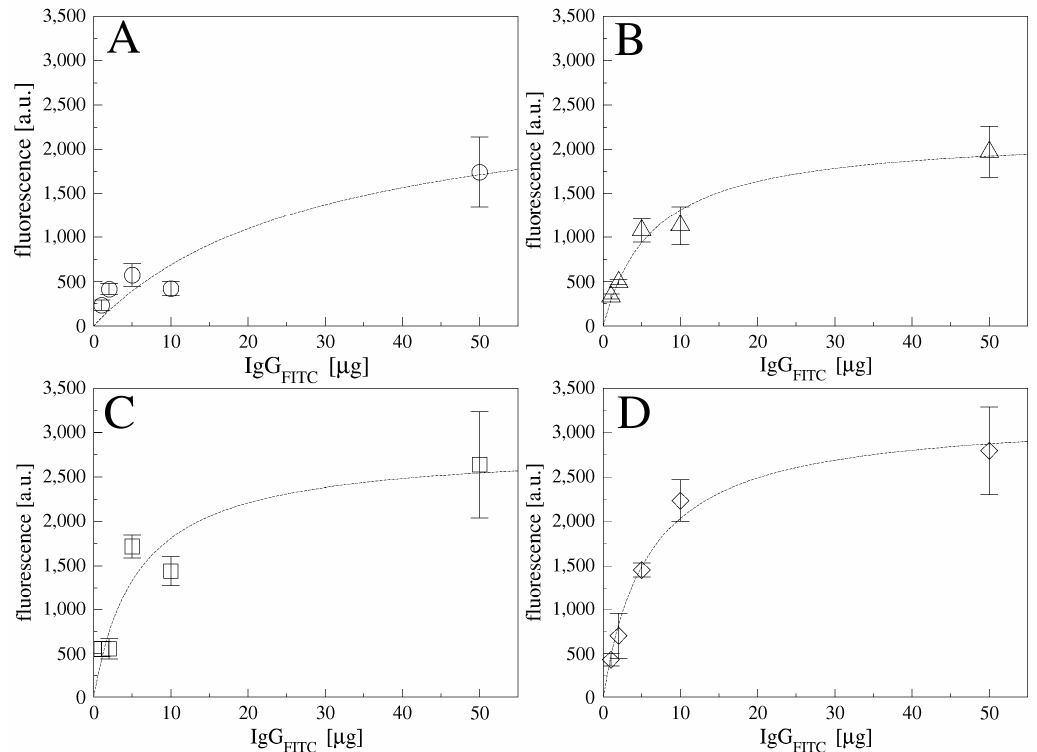
Figure 2. IgG FITC fluorescence on gold substrates functionalized at different concentration for different times: 20 min ( A ), 40 min ( B ), 60 min ( C ) and 120 min ( D ). Data are reported as mean value of five images acquired on the samples and error bars represent standard